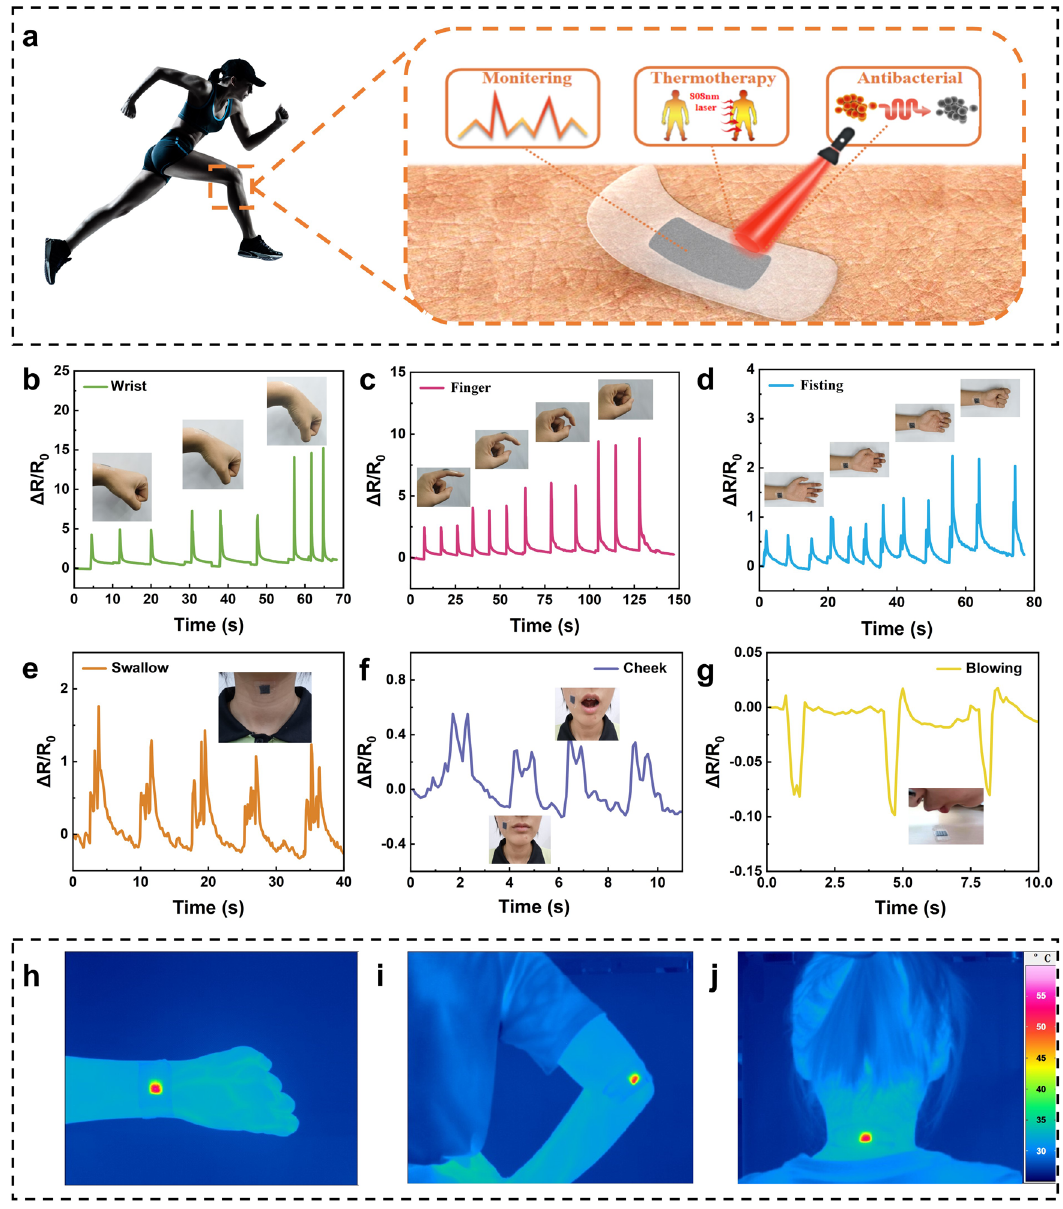
Fig. 8 Multifunctional device for sports rehabilitation medical. a Schematic illustration showing an integrated multifunctional sensing system (sensing, heat treatment and sterilization) for sports rehabilitation. Resistance variation of PMPPF sensors when monitor large body deformation, such as b wrist and c fi ngers bend. Insets: digital images of the wrist and index fi nger at different angles. Resistance variation of PMPPF sensors when monitor small body deformation, such as d fi sting, e swallow, f mouth open/close and g blowing. Insets: digital images of different stages of fi st clenched, swallow, mouth and blowing. IR images of PMPPF sensor under infrared light at 50 °C for hot application on the h wrist, i elbow, j 25 sensor units are pasted in two ultra-thin insoles to develop a continuous and real-time pressure distribution monitoring system (Fig. 9d, Supplementary Fig. 15). Two common walking postures, the out-toe and in-toe, are imitated to re fl ect the plantar compression through Δ R at the fi ve monitoring sites. Clearly,